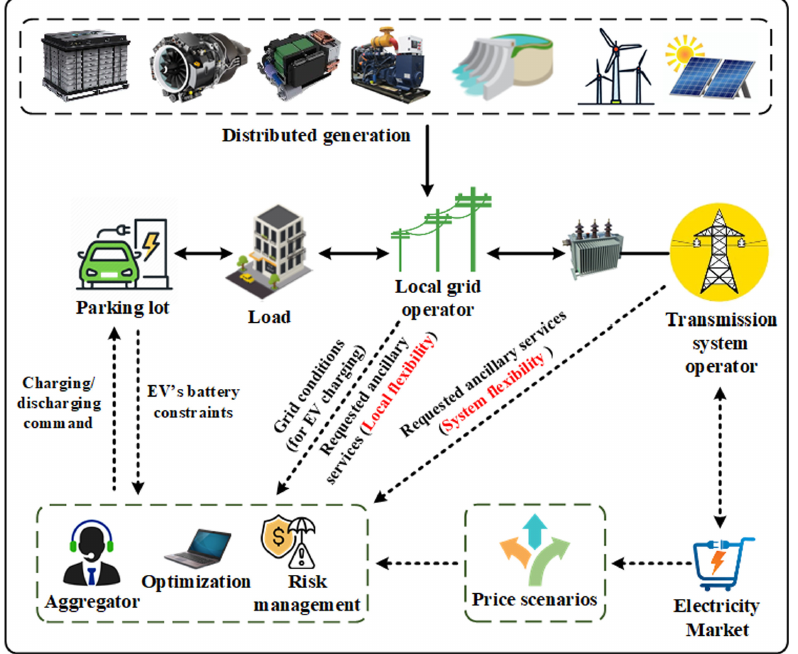
Figure 1. A diagrammatic representation illustrating the charging process of plug-in hybrid electric vehicles within power distribution